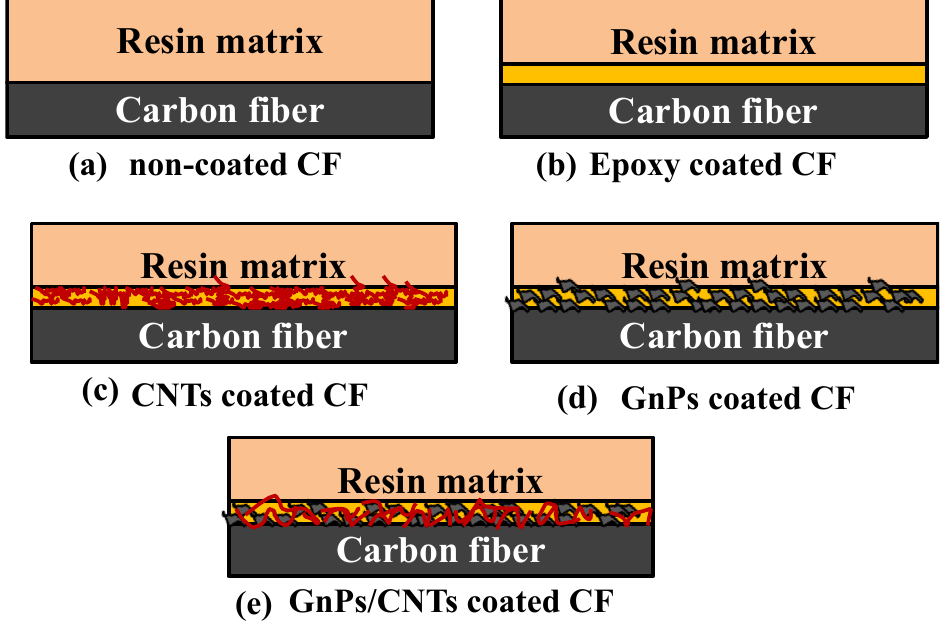
Figure 6. Schematic of the interphase of the composites: ( a ) non-coated CF, ( b ) epoxy coated CF, ( c ) GnPs coated CF, ( d ) CNTs coated CF and ( e ) GnPs/CNTs coated CF.